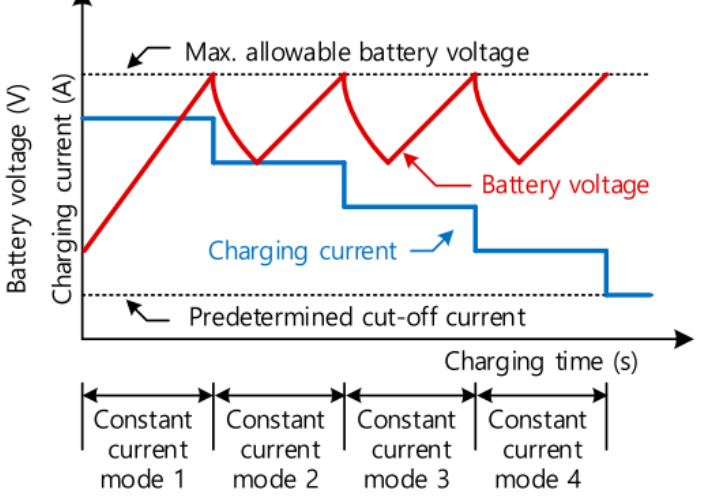
Figure 2. MSCC with five steps